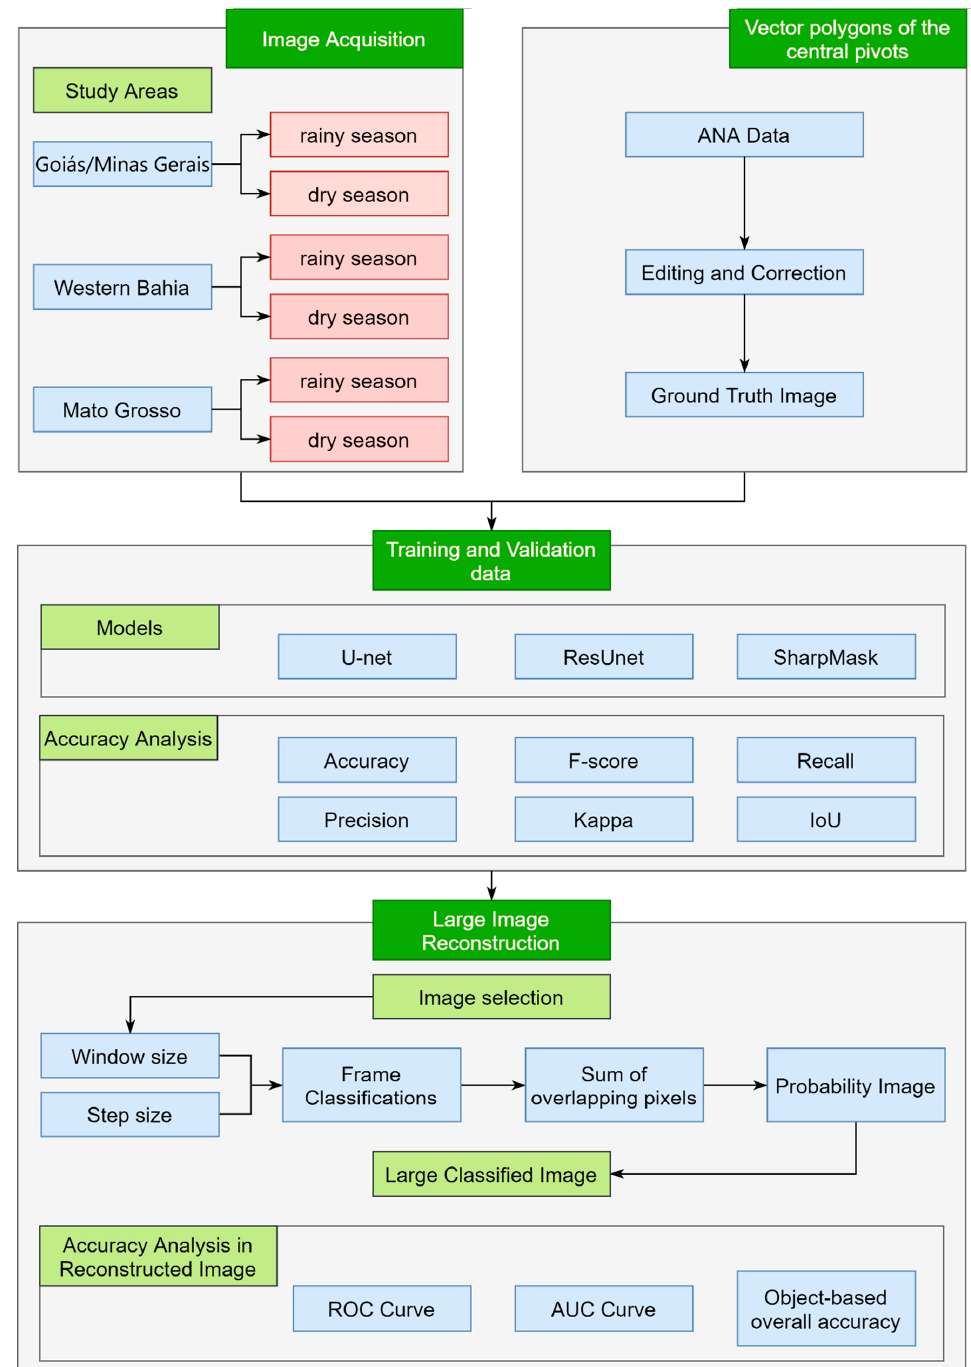
Figure 1. Methodological flowchart of deep semantic segmentation of center pivots.